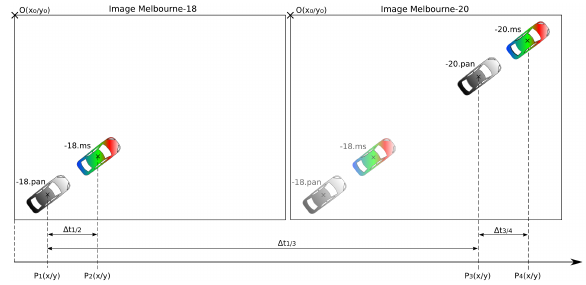
Figure 12: Time calibration for WorldView-2 stereo imagery; left: a car with positions in red and yellow channel of the first stereo image; right: the same car in the second stereo image